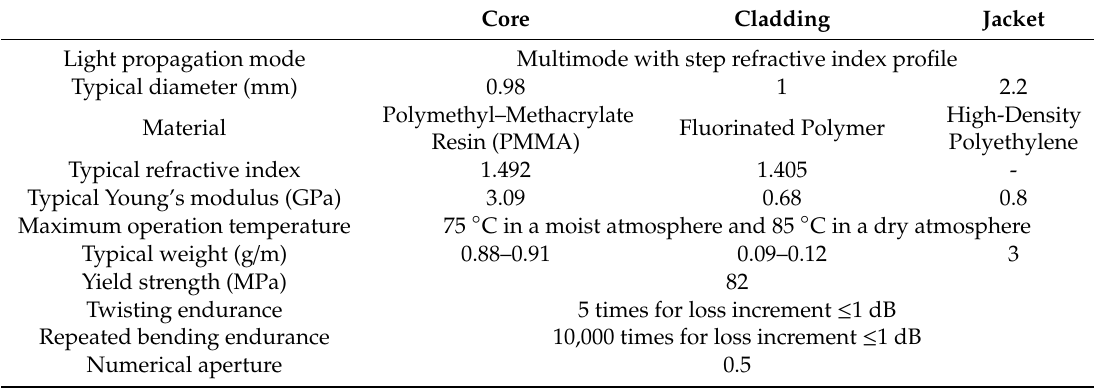
Table 2. Properties of the Polymethyl–Methacrylate Resin (PMMA) polymer optical fibres (POFs) adopted in this adopted in this study.